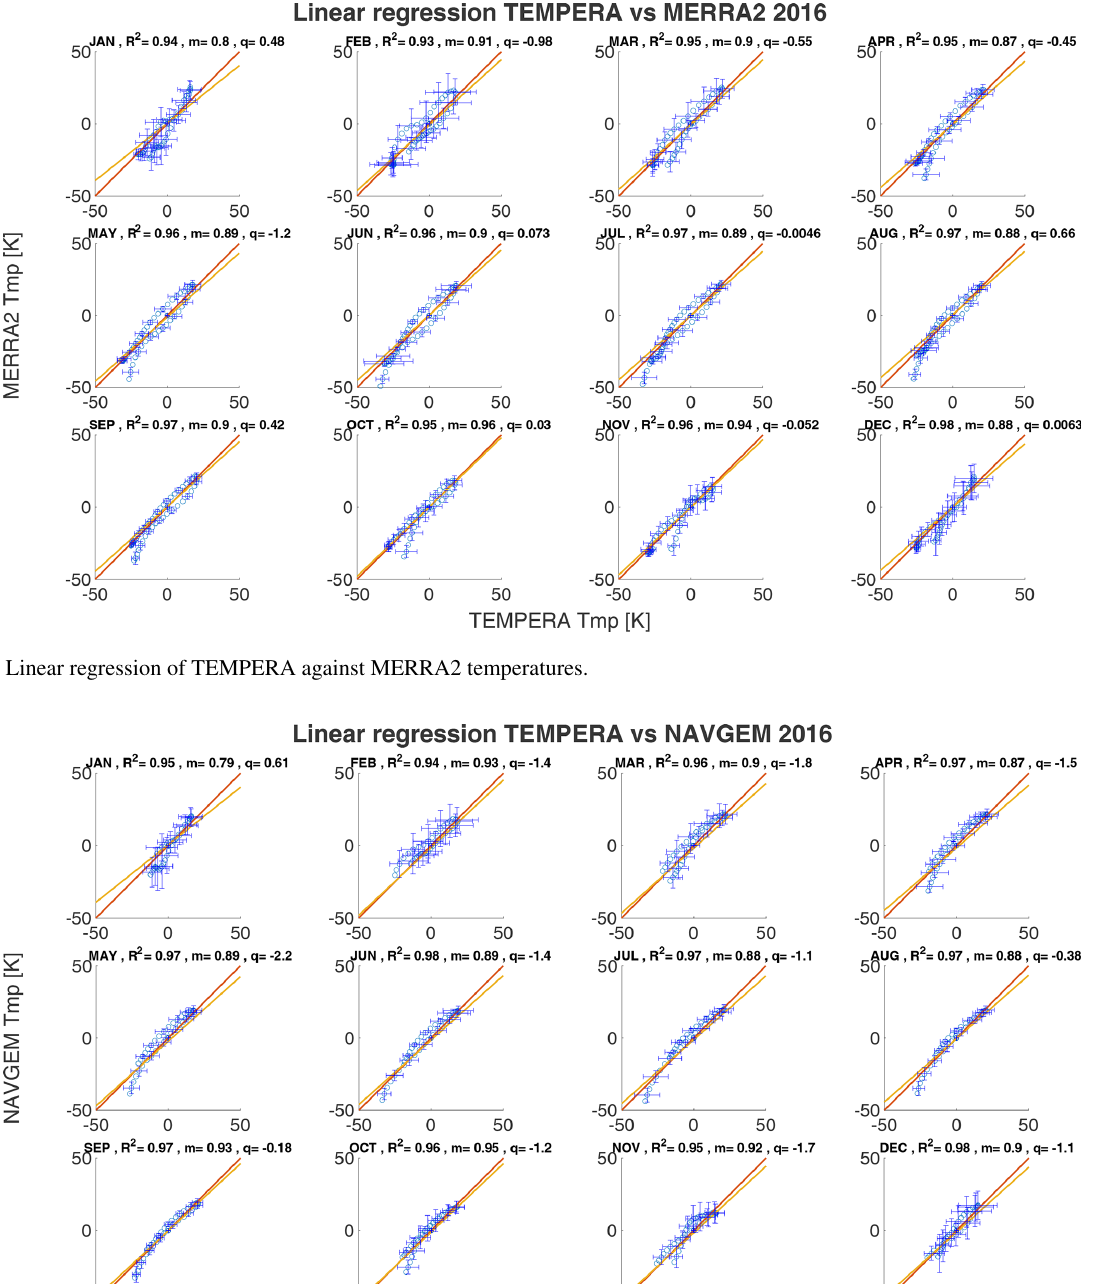
for TEMPERA to show warmer temperatures compared to MERRA2 and NVAGEM-HA. Between 35–50, the models seem to have a warm bias compared to the radiometric tem- perature sounding. Above 53 km MERRA2 indicates a clear tendency to underestimate the temperatures relative to TEM-